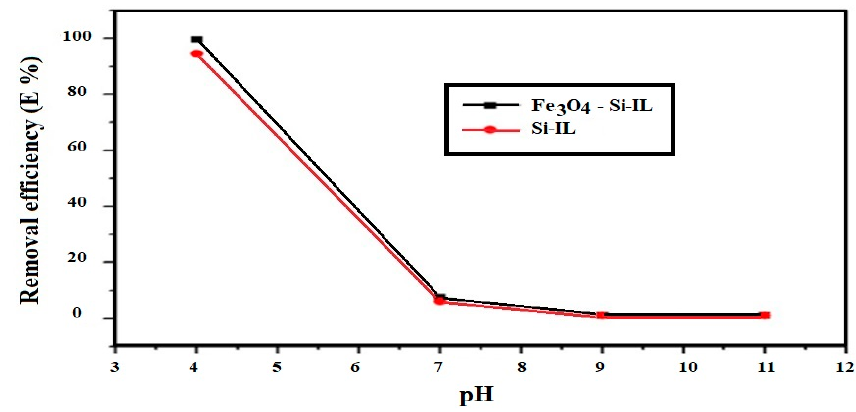
Figure 10. Effect of pH on the removal efficiency ( E %) of Si-IL and Fe 3 O 4 -Si-IL at 0.1 M ionic strength and room temperature.